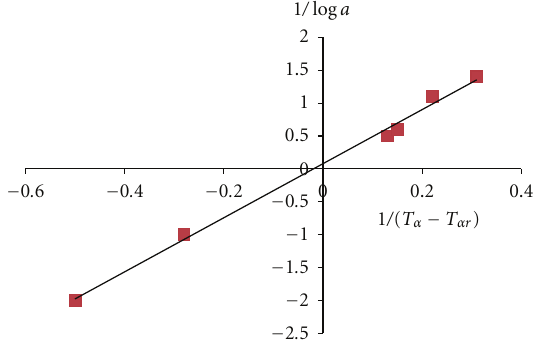
Figure 4: Linear regression of WLF equation in the region of α tran- sition.